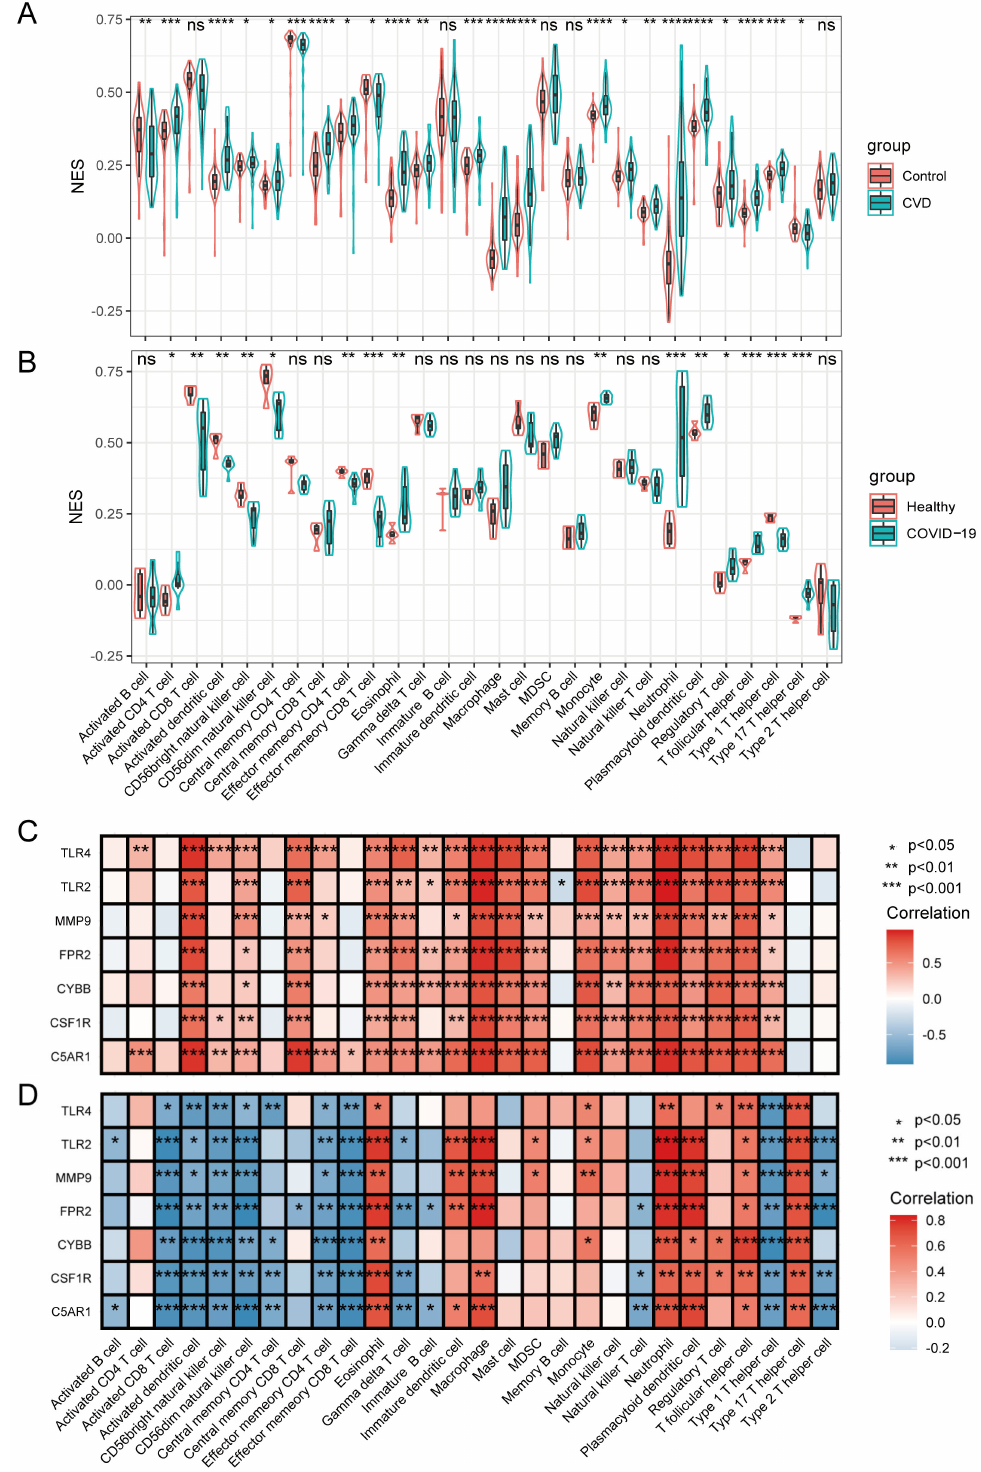
Figure 5. Immune-related hub gene signatures correlated with immune infiltrations. ( A , B ) Immune cell infiltration analysis in GSE66360 and GSE164805 datasets. ( C , D ) Correlation analysis between immune-related hub genes and infiltrating immune cells. * indicates p < 0.05, ** represents p < 0.01, *** represents p < 0.001, **** represents p < 0.0001, ns represents no significant